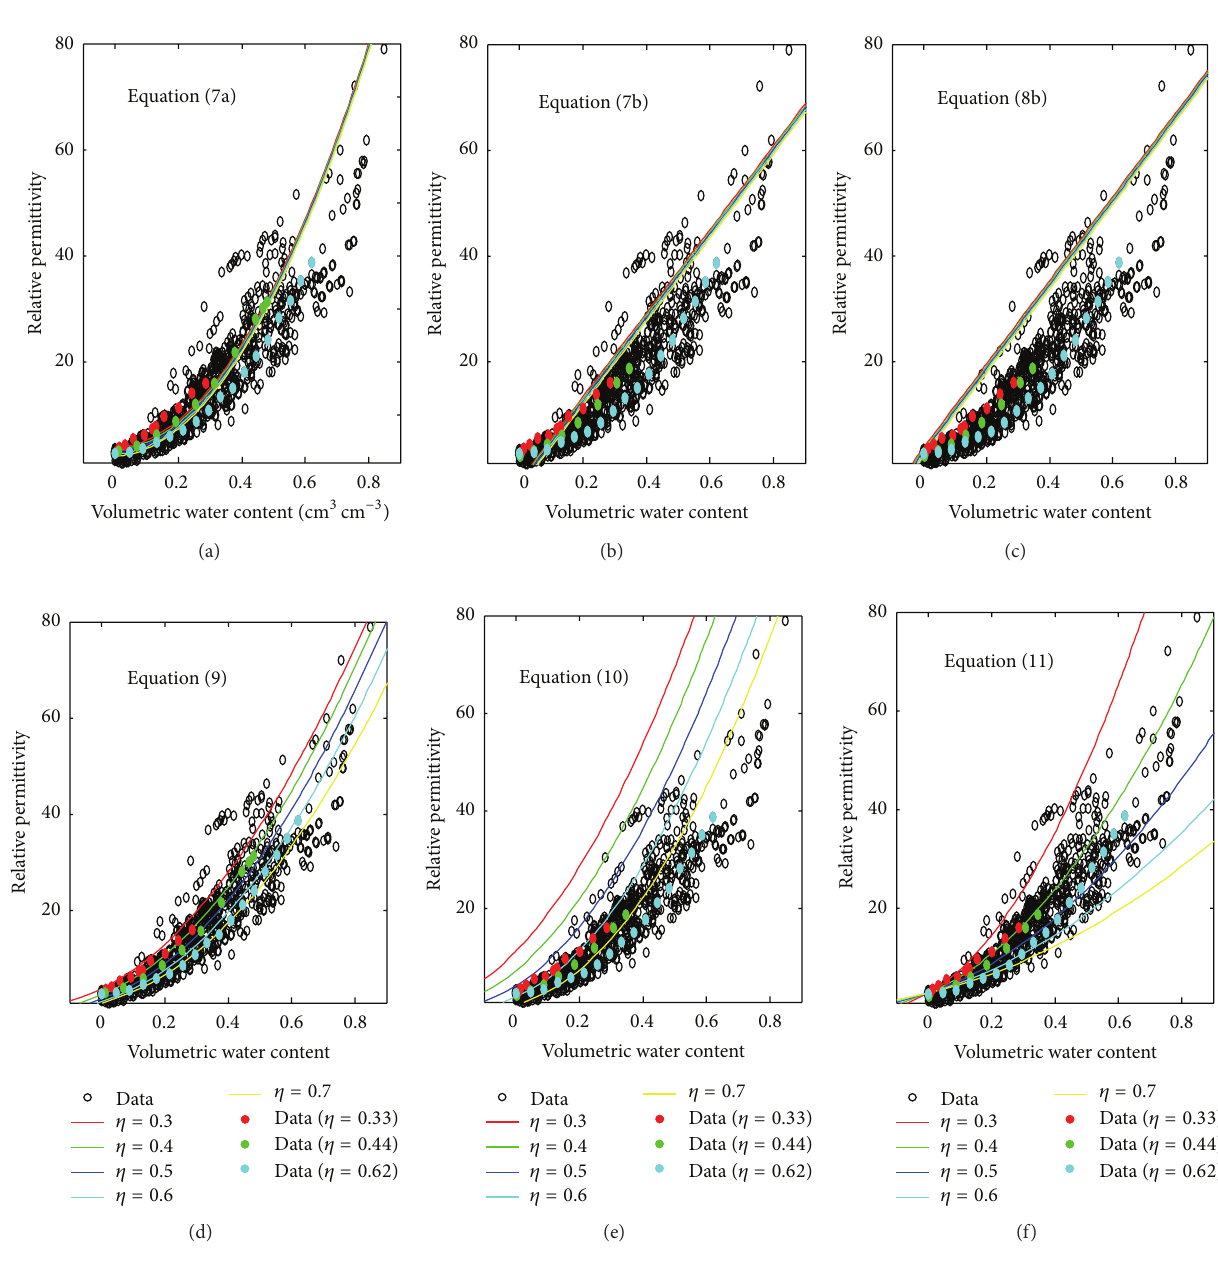
Figure 3: Comparison of (7a) to (11) with all data and different